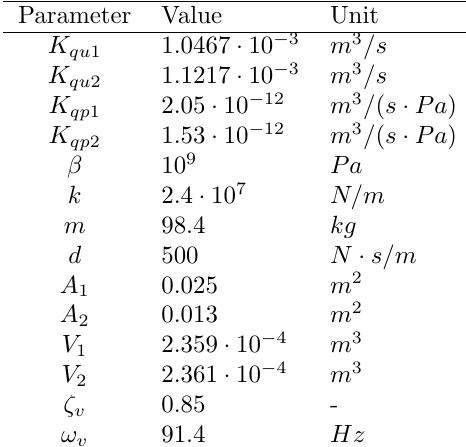
Table 1: Overview of system parameters.